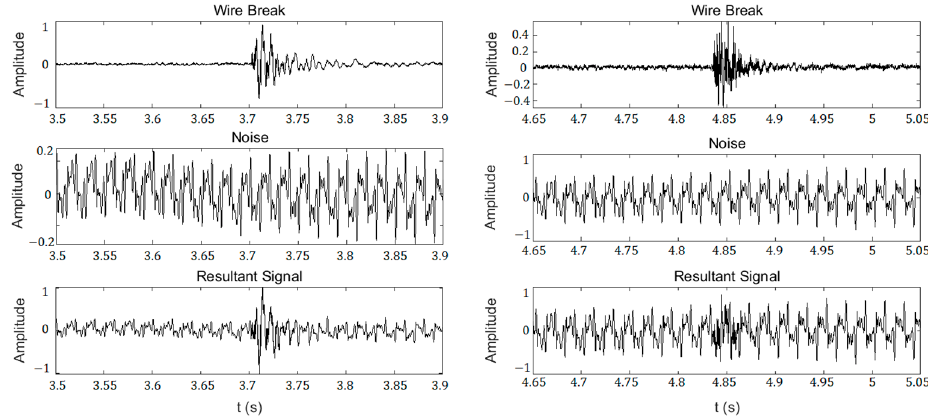
Figure 7. Typical acoustic signal combination processes.